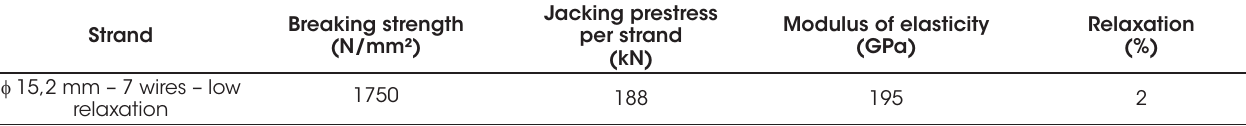
Design material properties of prestressing strands (AS